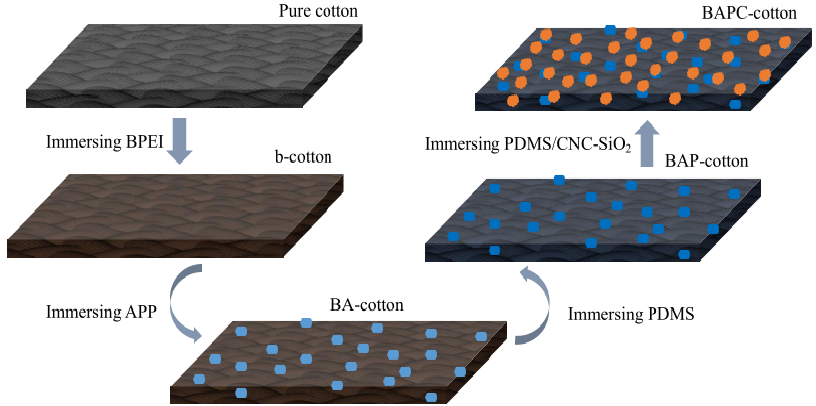
Figure 1. Formation mechanism of flame-retardant and superhydrophobic cotton fabric.